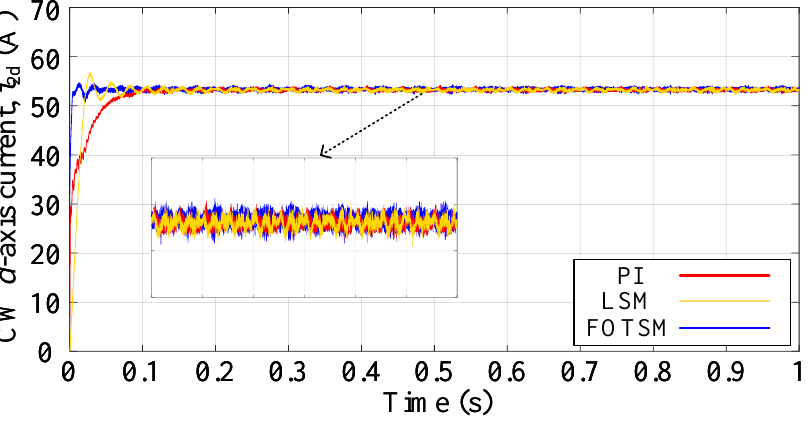
Figure 4. The CW d -axis current responses under PI, LSM, and FOTSM during the start-up